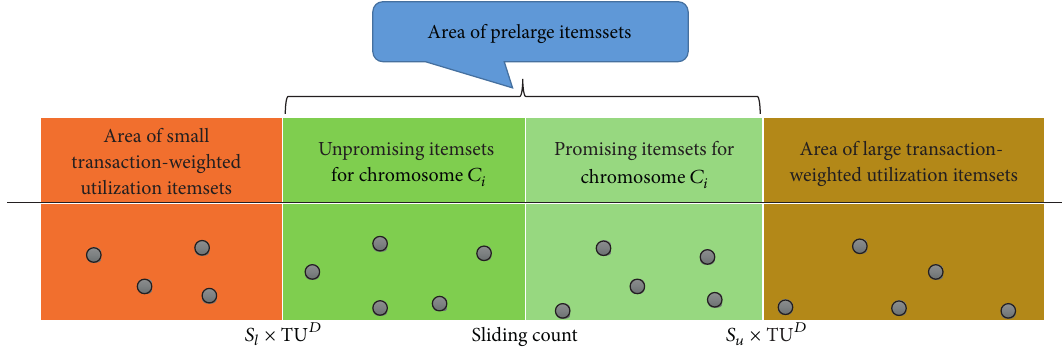
Figure 4: The relation between upper threshold, sliding count, and lower